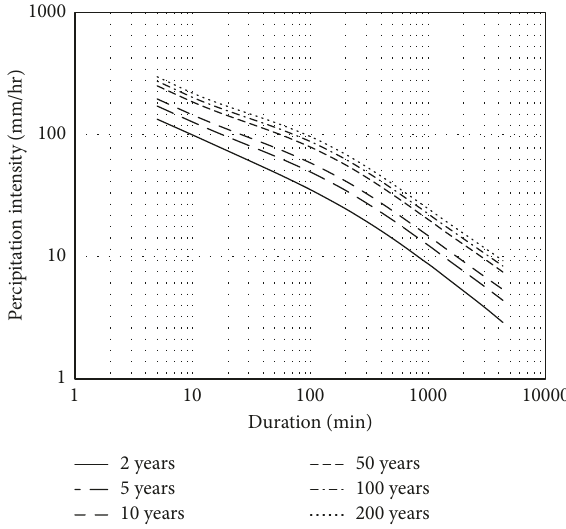
Figure 8: IDF curves for study site.